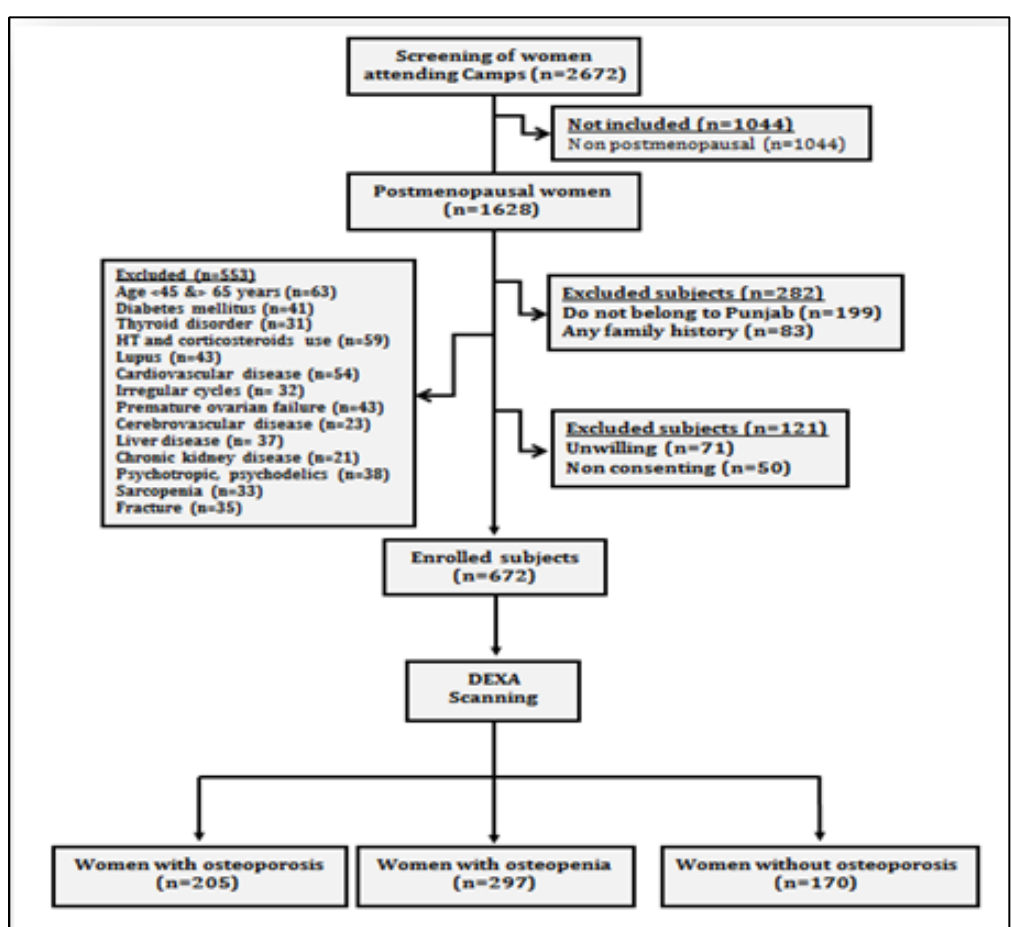
Figure 2. Study flow chart showing data collection protocol.